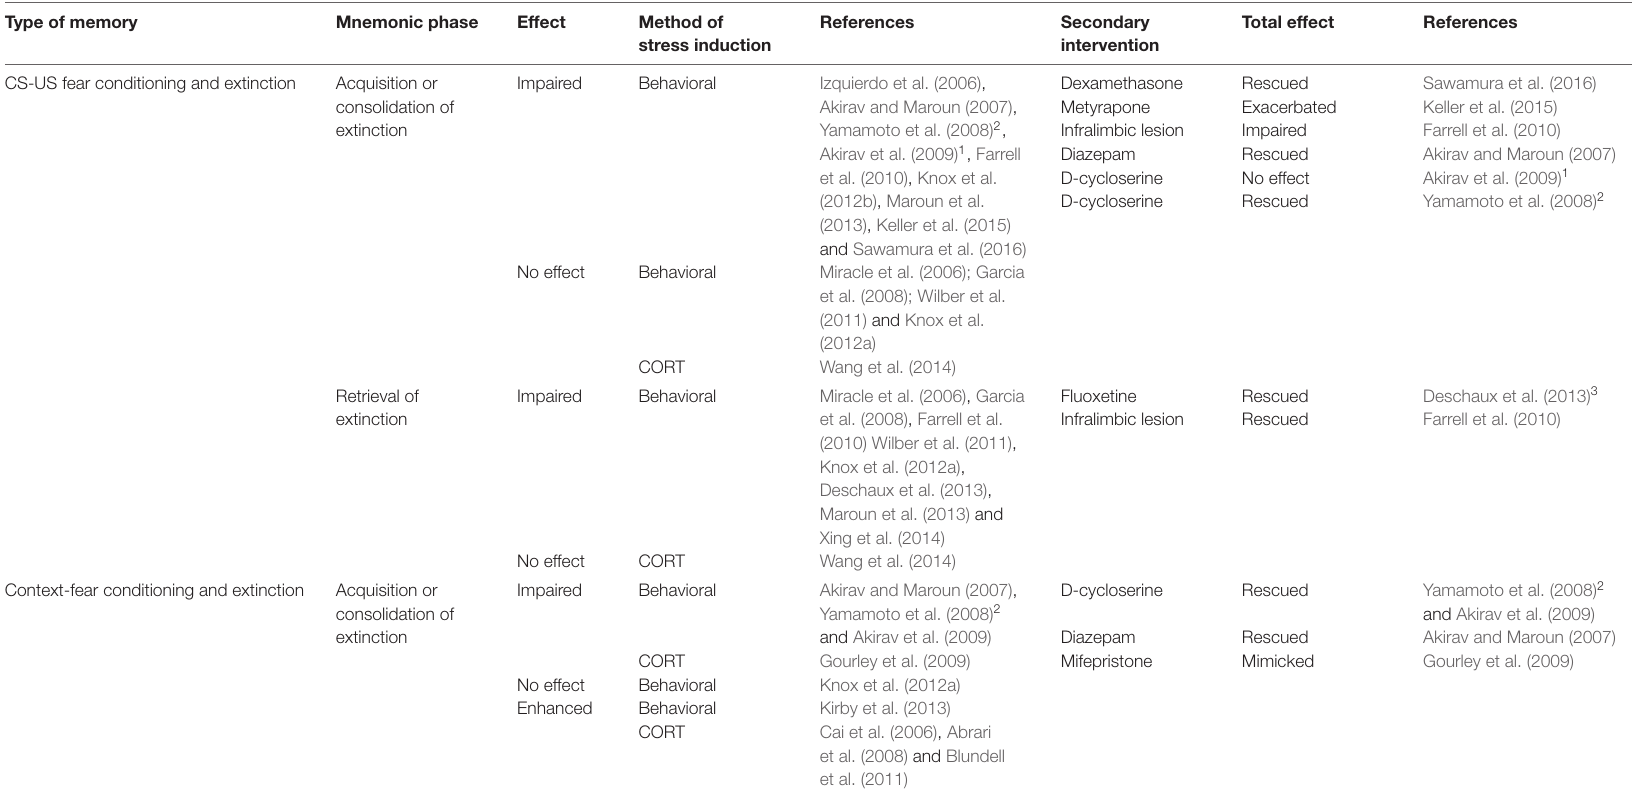
TABLE 1 | Modulation of different phases of extinction by behavioral stress, glucocorticoid administration, and secondary